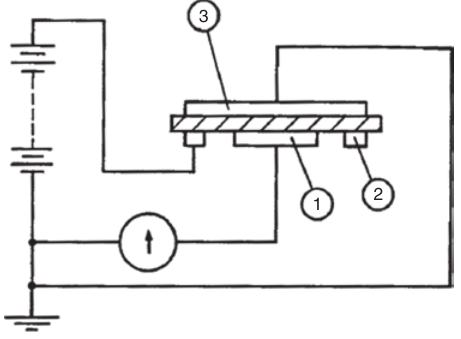
Figure 7 Surface resistivity electrode connections [19].